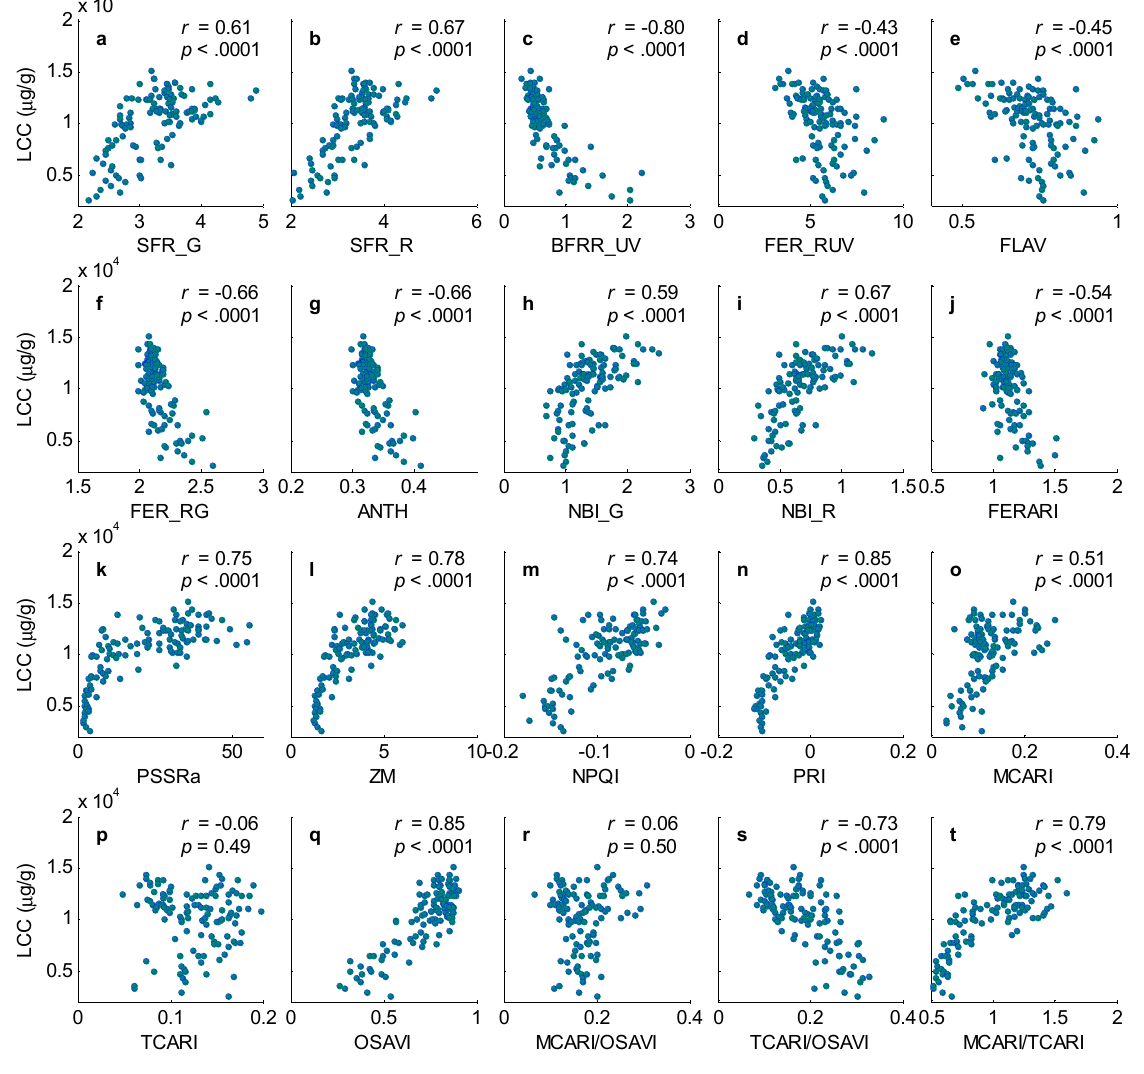
Figure 5. Scatter plots showing the relationships between LCC with ( a – j ) the ten fluorescence indices and ( k – t ) ten reflectance indices used in this study for the calibration data